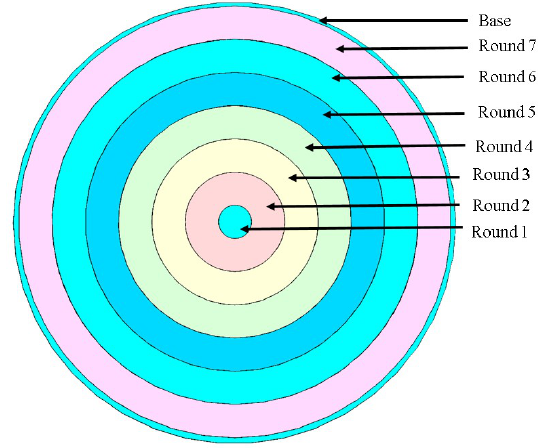
Figure 3. Flat concentric circular seven different